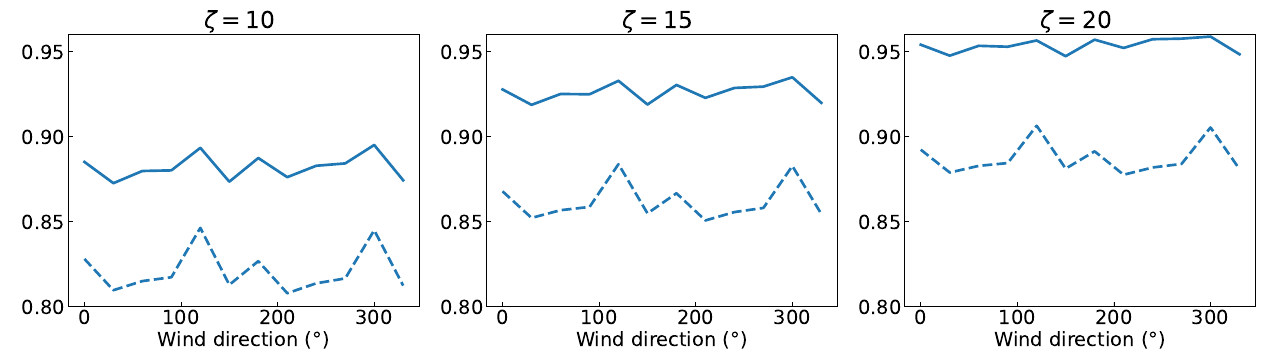
Figure 9. Wind speed reduction factors in Case A for all wind directions at U F 0 = 10 m/s. Solid lines show the farm-upstream wind speed reduction factor ( U (cid:48) farm-average wind speed reduction factor β ( = U F / U F 0